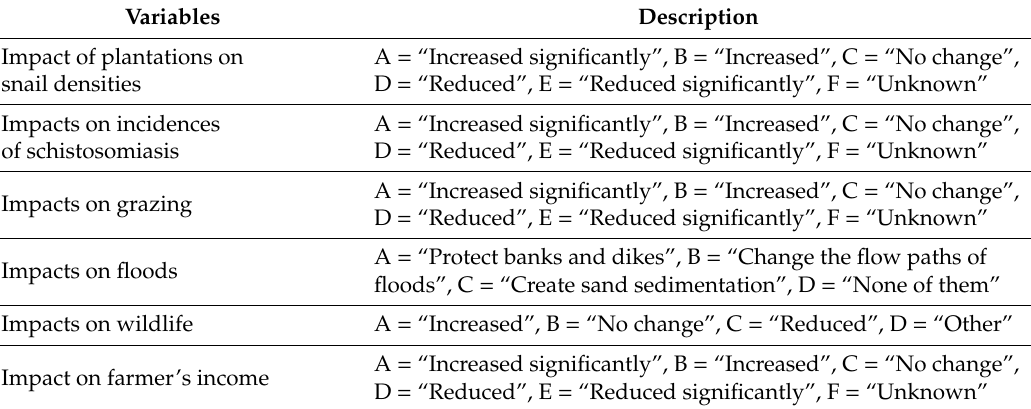
Table 1. Six questions used to compare the di ff erences in attitudes toward the planting program between administrators and farmers.